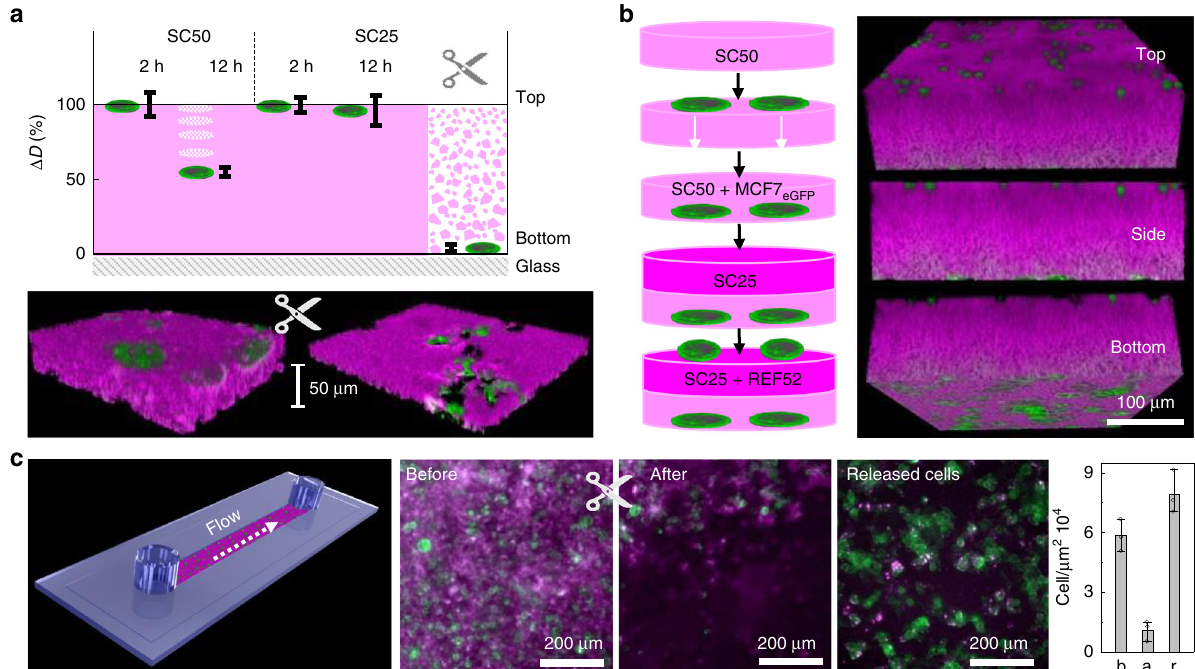
Fig. 5 Control of cellular transmigration and release. a Vertical transmigration controlled by time, material composition and on-demand matrix degradation. Δ D (%) represents the relative distance between cells and the glass substrate. The images show MCF7 eGFP on fresh SC25 before and after endonuclease digestion. b Scheme (left) and representative fl uorescence images (right) of a layered cell stack containing REF52 and MCF7 eGFP cells. c Flow-assisted capture and release of MCF7 eGFP in a microchannel coated with SC25 before and after endonuclease digestion and of the released cells. The bars show the average cell densities of the three